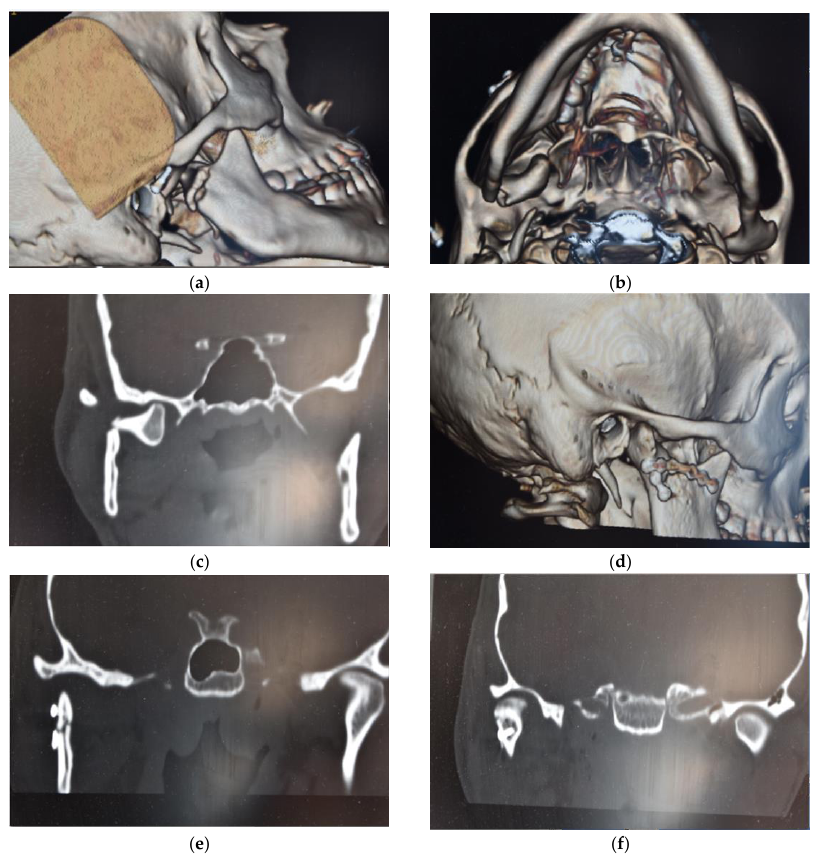
Figure 4. ( a , b ) Pre-operatory volumetric CT; ( c ) pre-operatory coronal CT; ( d ) post-operatory volumetric CT; and ( e , f ) post-operatory coronal CT of patient